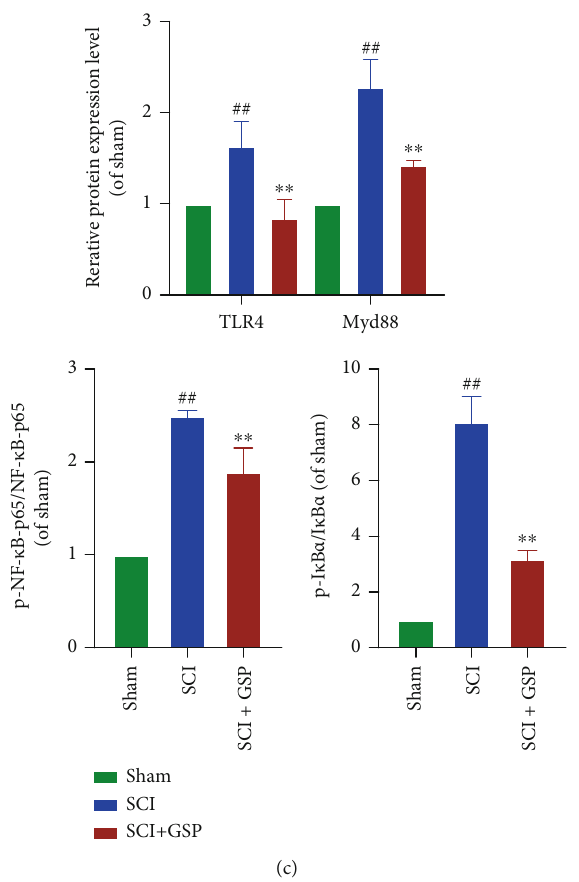
Figure 10: E ff ect of GSP on TLR4/NF- κ B/PI3K/AKT signaling cascades in vivo . (a) Representative WB and quantitative analysis of TLR4. (b, c) Representative WB and quantitative analysis of TLR4/MyD88/NF- κ B/PI3K/AKT signaling cascades in each group. ## p < 0 : 01 vs. sham group. ∗∗ p < 0 : 01 vs. SCI